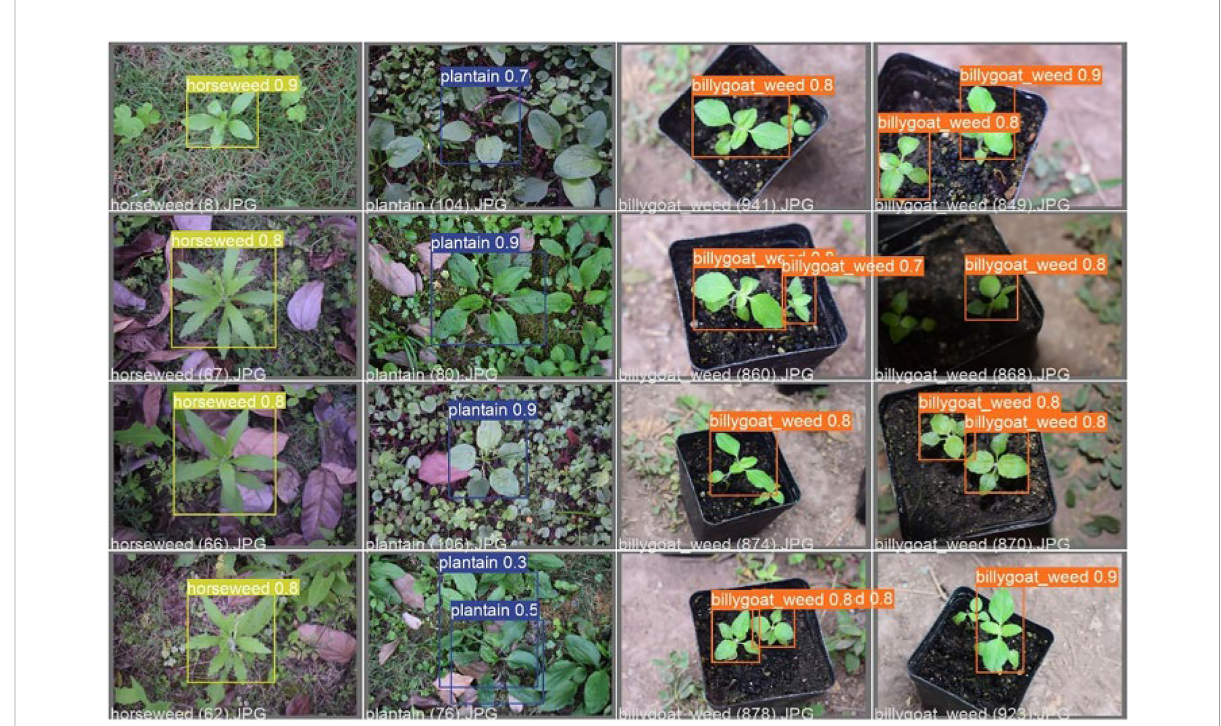
FIGURE 8 Effect diagram of weed prediction of the You Only Look Once model (in the notes above the detection box, the name of the weed is on the left, and the precision of the weed is on the right).